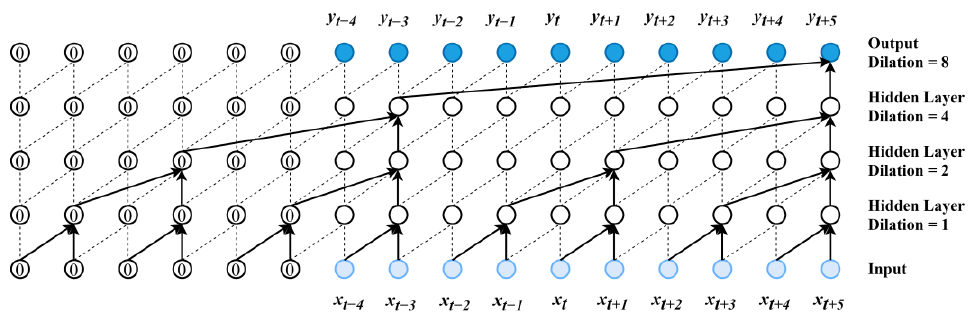
Figure 2. Visualization of a stack of dilated causal convolutional layers.